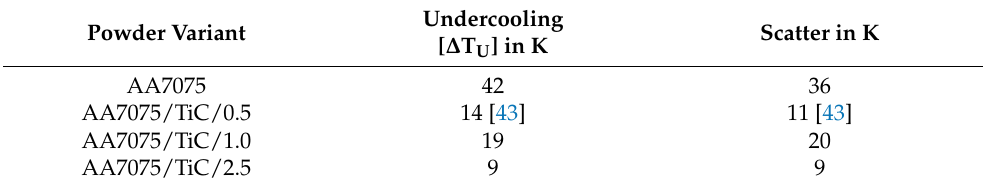
Table 2. Undercooling during solidification and its scatter for various powder variants.